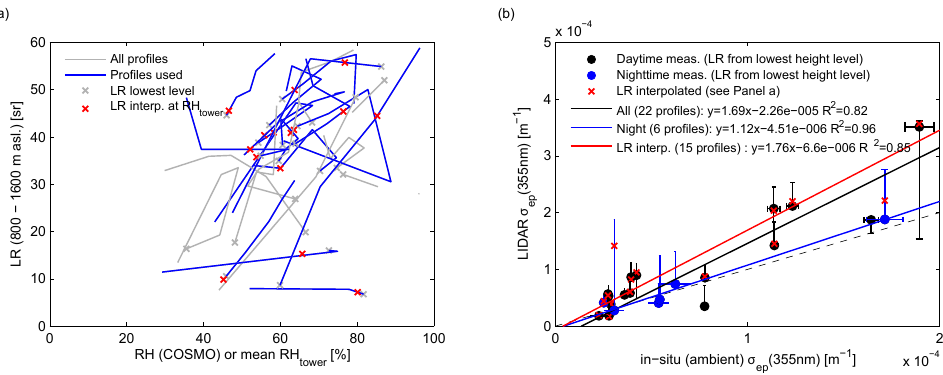
Fig. 12. Panel (a) : The LIDAR ratio LR measured in 200-m altitude intervals between 700 and 1700m versus the RH in the individual layer (taken from COSMO). Grey crosses denote the LR of the lowest layer, red crosses show the interpolated LR for the RH measured at the ground (mean 60–200m). The profiles used to retrieve the interpolated value are shown in blue. Grey are all profiles (where no interpolation was possible or where no WetNeph measurements were available). Panel (b) : Comparison of the extinction coefficient σ ep at the ground retrieved from LIDAR vs. the in-situ values (mean for 60–200m). Circular points denote the mean value if the LR from the lowest level is taken (black daytime measurements; blue nighttime measurements). Red crosses show the mean value if the LR interpolated to the ground RH is taken (see Panel a ). The y-error bars give the range of the retrieved σ ep taking the measured minima and maxima LR of the upper layer. The x-error bars give the calculated error in the ambient in-situ measurement. The solid lines represent linear orthogonal regressions (see